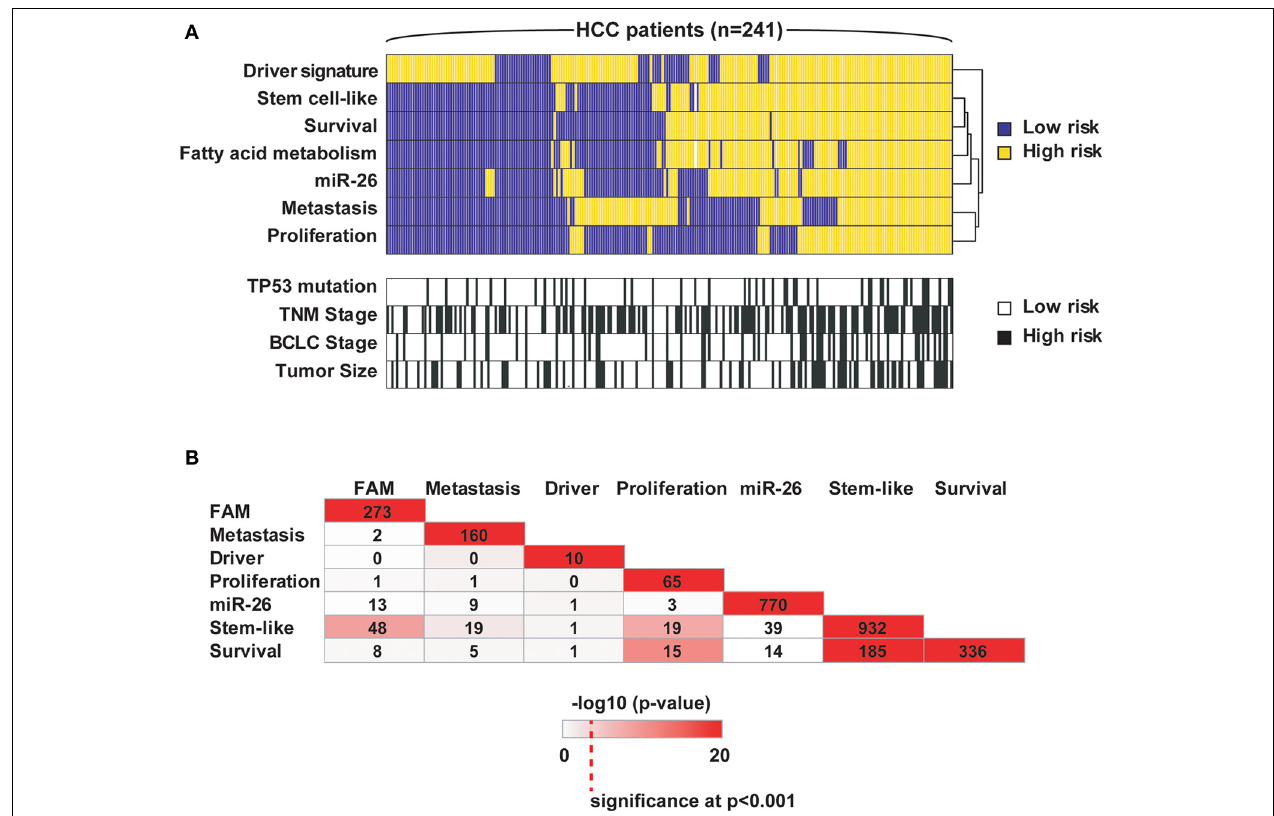
FIGURE 1 | Seven independent gene signatures predict concordant outcome groups. (A) Each of the 241 HCC patients (columns) was assigned into high and low risk groups based on hierarchical clustering of the prediction results of the 7 independent gene signatures, TP53 mutation status (wild type vs. mutated), tumor size ( < 5cm vs. > 5cm), TNM staging (I vs. II/III) and BCLC staging (A vs. B/C); each tumor subclassification (rows)